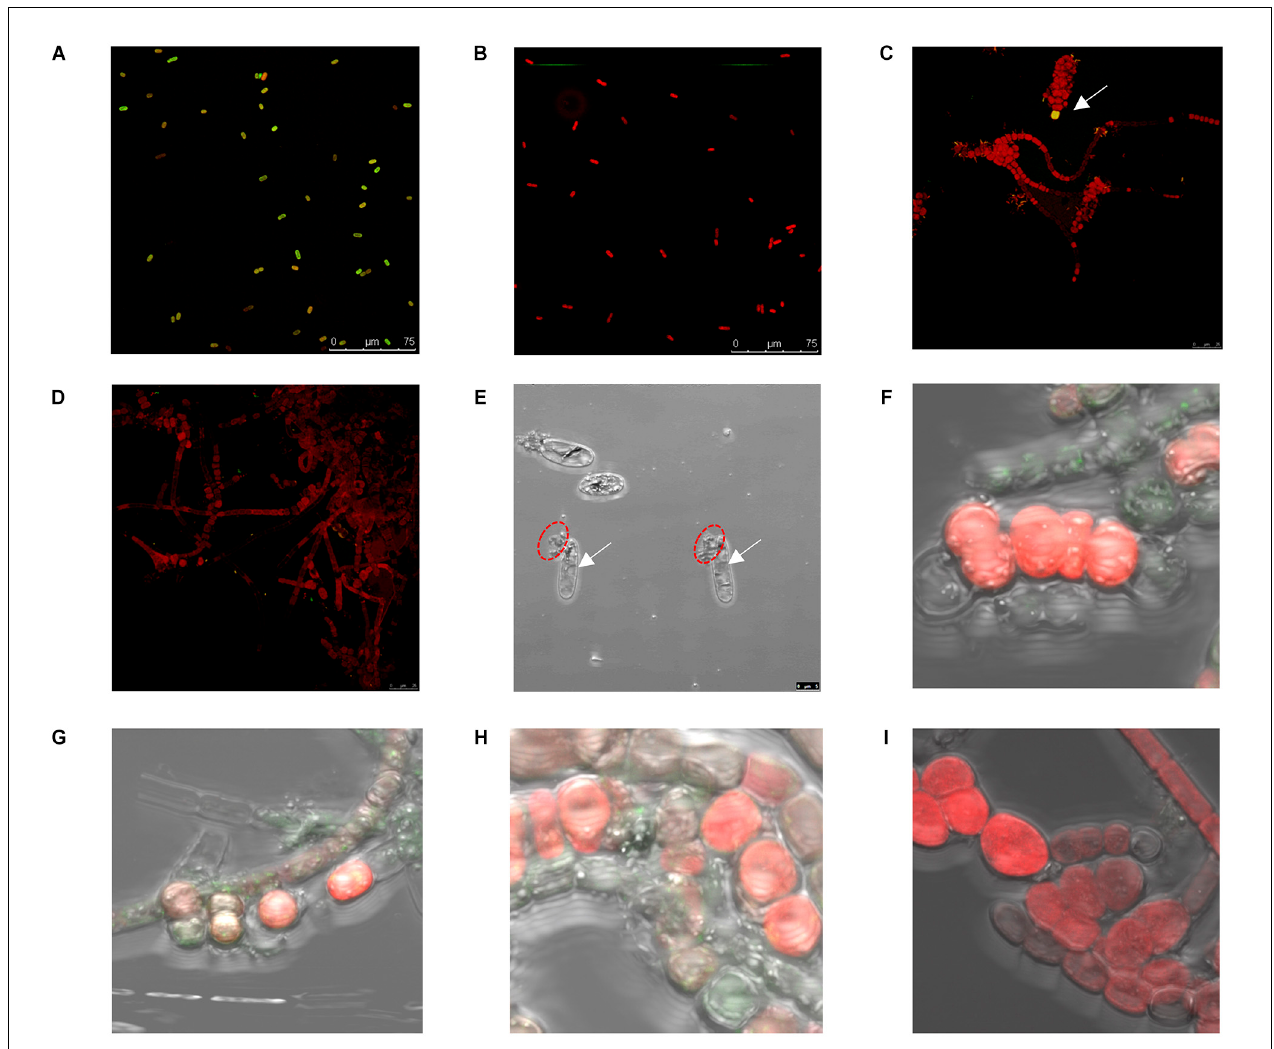
FIGURE 7 | Biochemical [e.g., reactive oxygen species (ROS) production], morphological, and physiological changes for Halothece sp. and Fischerella muscicola . (A–D) Confocal images of ROS production (green-yellow color) for Halothece sp. at panel (A) [Low PO 43 − –Low Fe] and panel (B) [High PO 43 − –High Fe] conditions and for F. muscicola at panel (C) [Low PO 43 − –Low Fe] (in which the white arrow indicates the ROS production) and panel (D) [High PO 43 − –High Fe] conditions. Images were taken at 400 × . Panel (E) [Low PO 43 − –Low Fe] condition under extremely limiting NO 3 − conditions under the bright field (arrows indicate vacuole formation, and red dashed circles indicate cell breaks). (F–I) Apoptosis assay results for F. muscicola under confocal microscopy. Panel (F) [Low PO 43 − –Low Fe], panel (G) [Low PO 43 − –High Fe], panel (H) [High PO 43 − –Low Fe], and panel (I) [High PO 43 − –High Fe]. In panels (F–I) , the green color resulted from the binding